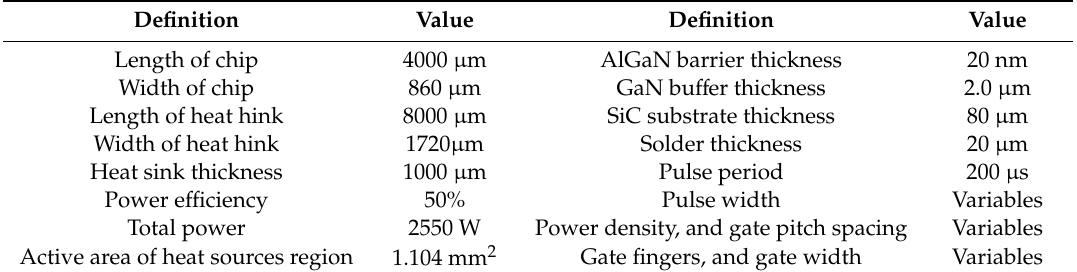
Table 1. Geometric and working parameters of the designed device.